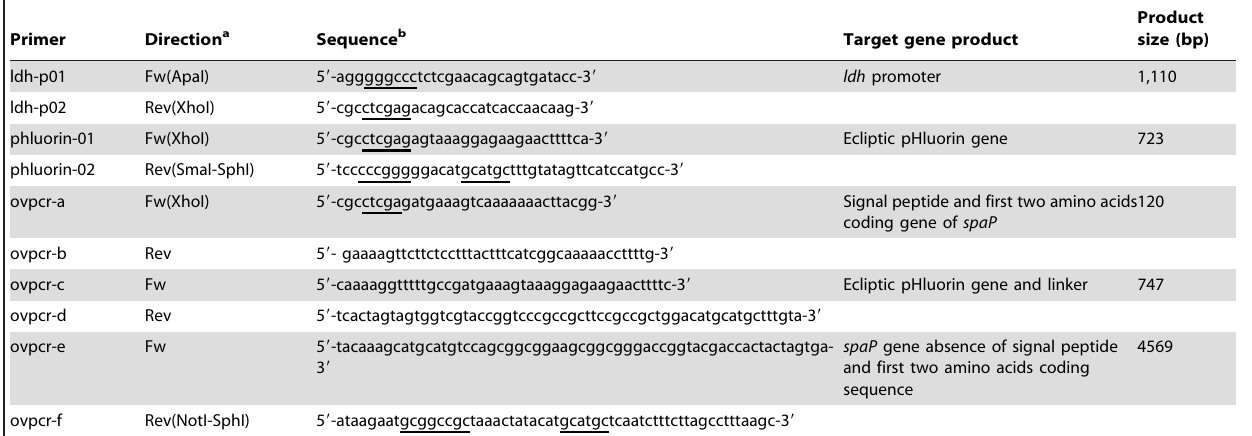
Table 1. Primers used in this study.